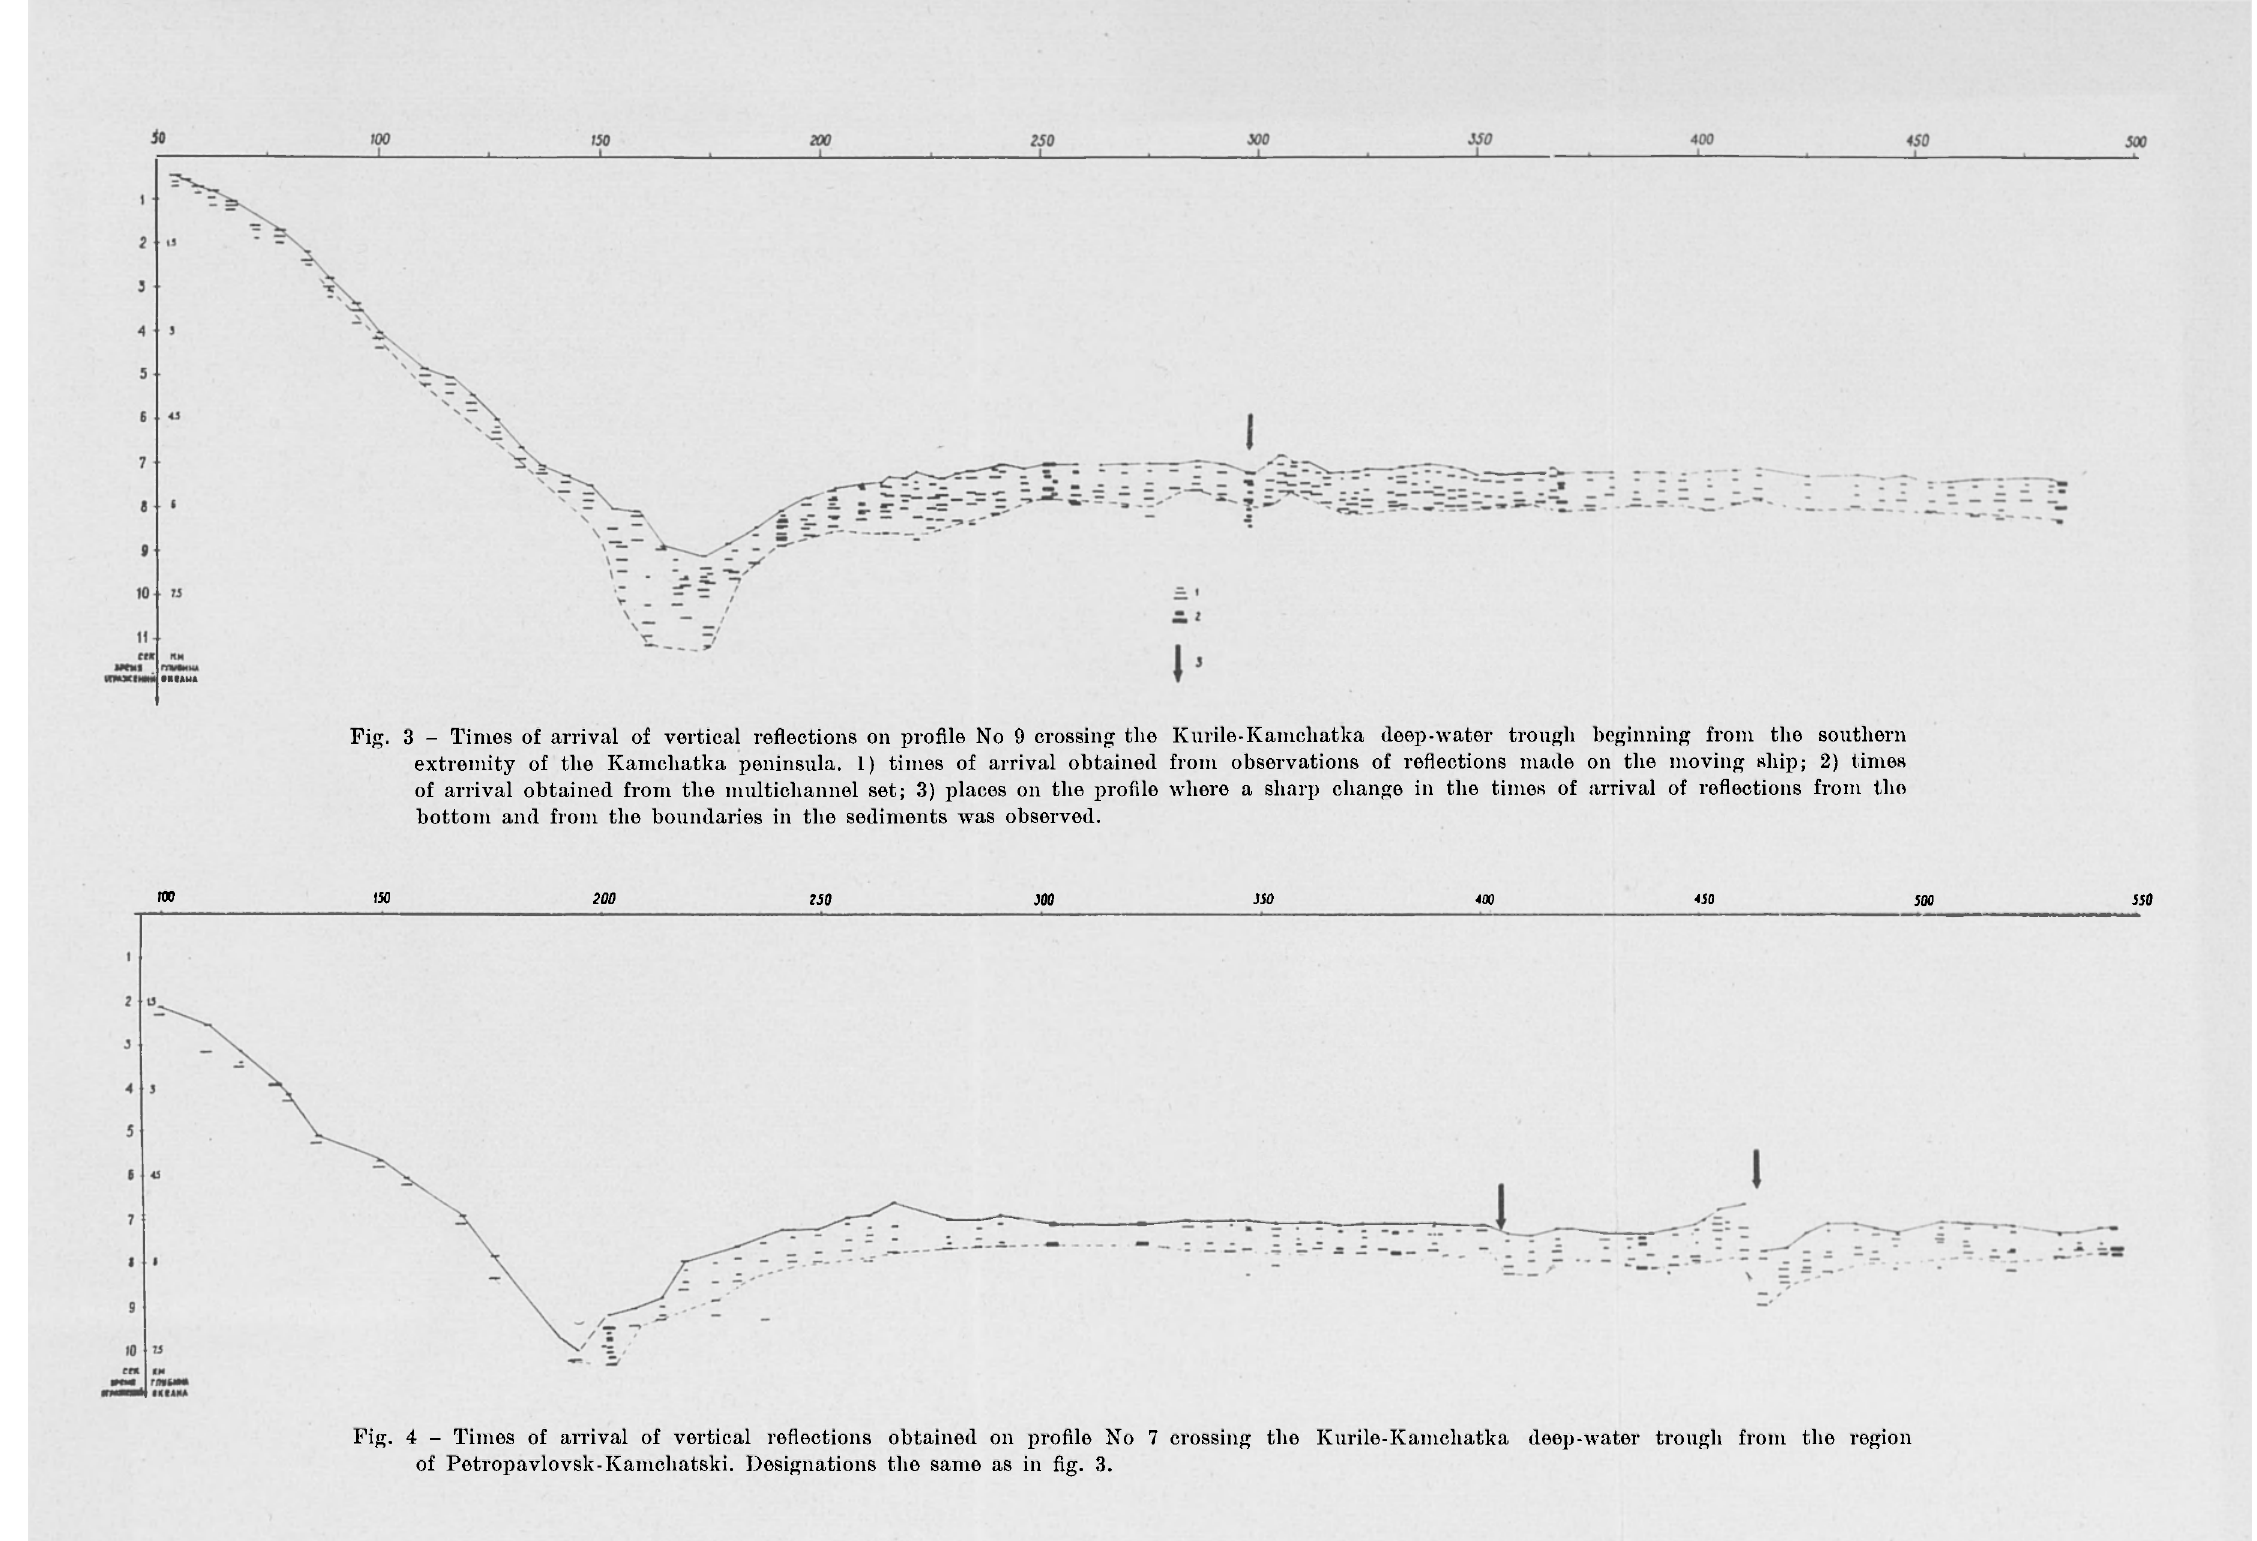
Pig. 4 - Times of arrival of vertical reflections obtained on profile No 7 crossing the Kurile-Kamchatka deep-water trough from the region of Petropavlovsk-Kamchatski. Designations the same as in fig.